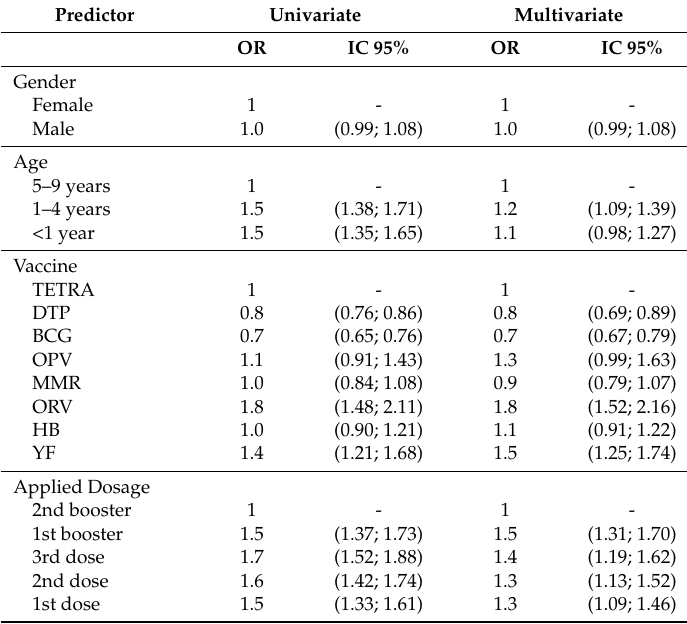
Table A3. Odds ratio (OR) of hospitalization for adverse postvaccination cases and the 95% confidence interval in the univariate and multivariate models using the studied predictors, considering a logistic regression model for correlated data (GEE) for single inoculation